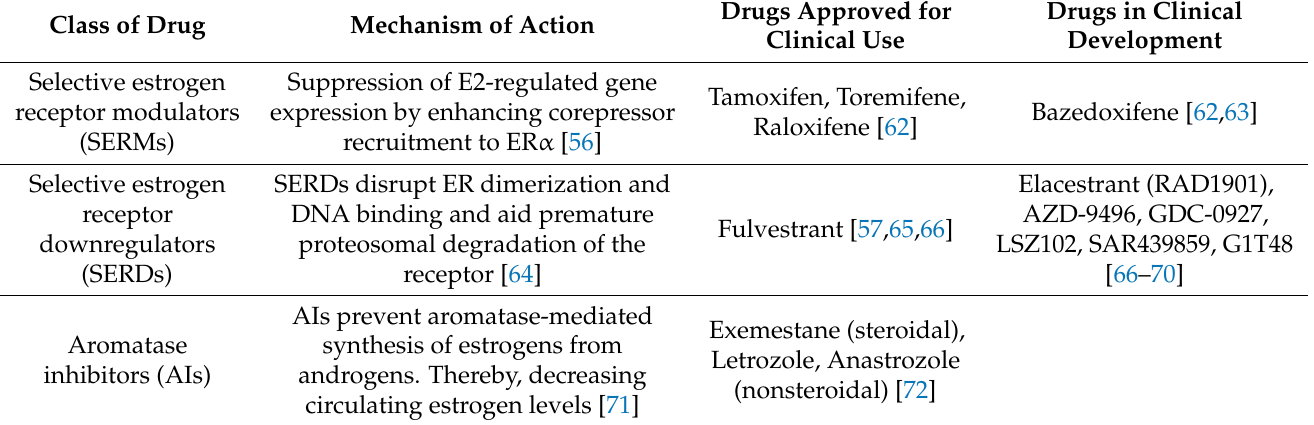
Table 1. SERMs/SERDs/AIs that are clinically used or under clinical